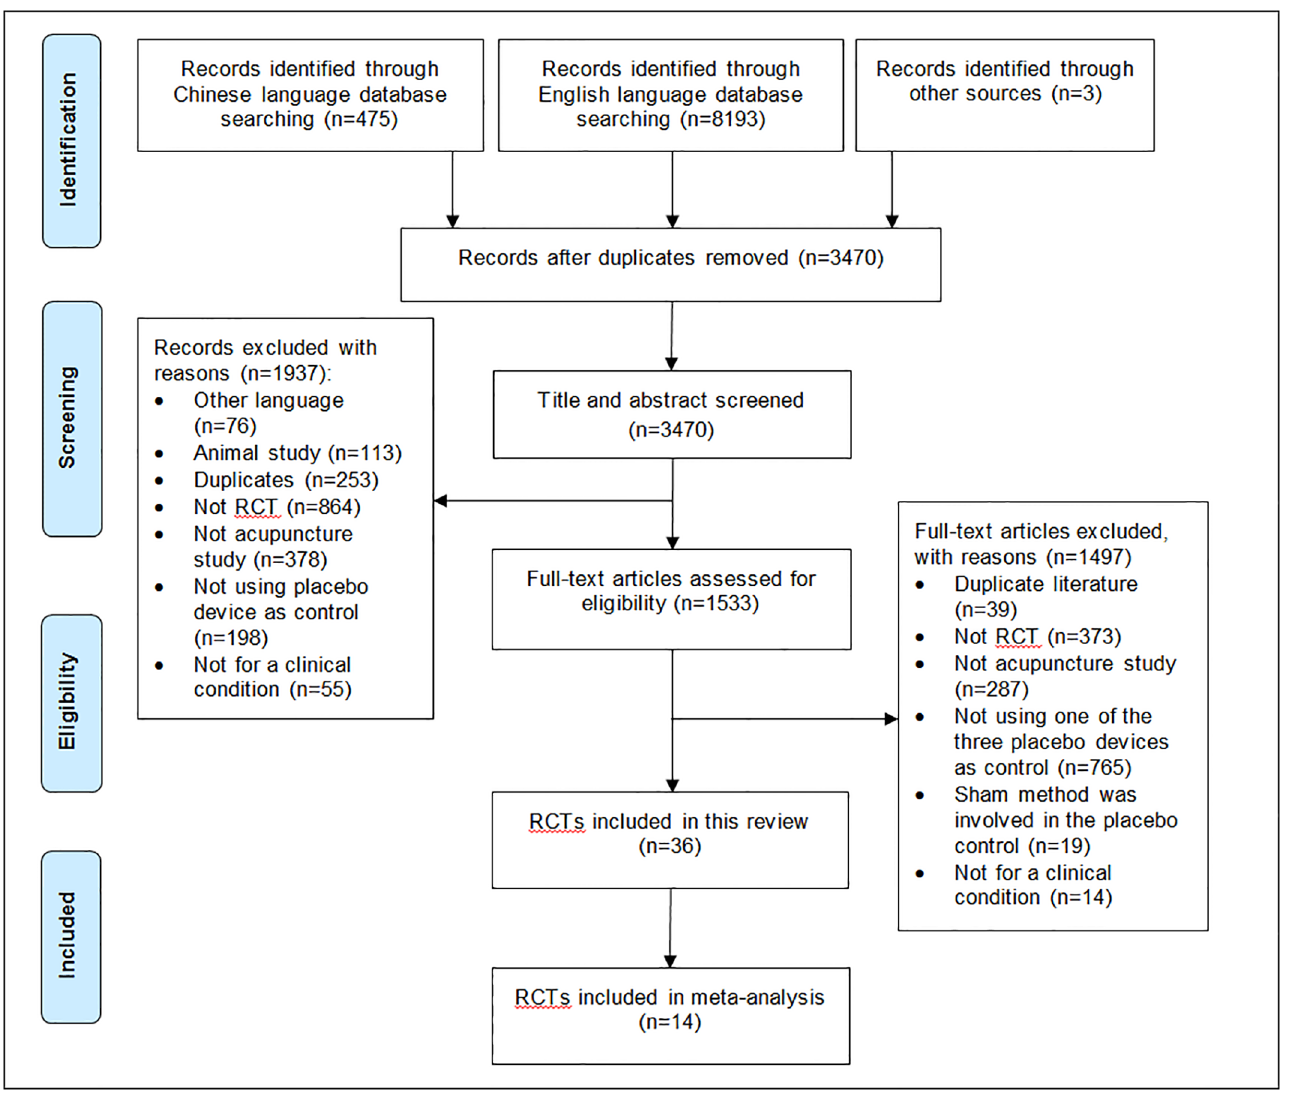
Fig 1. PRISMA flow diagram of study selection